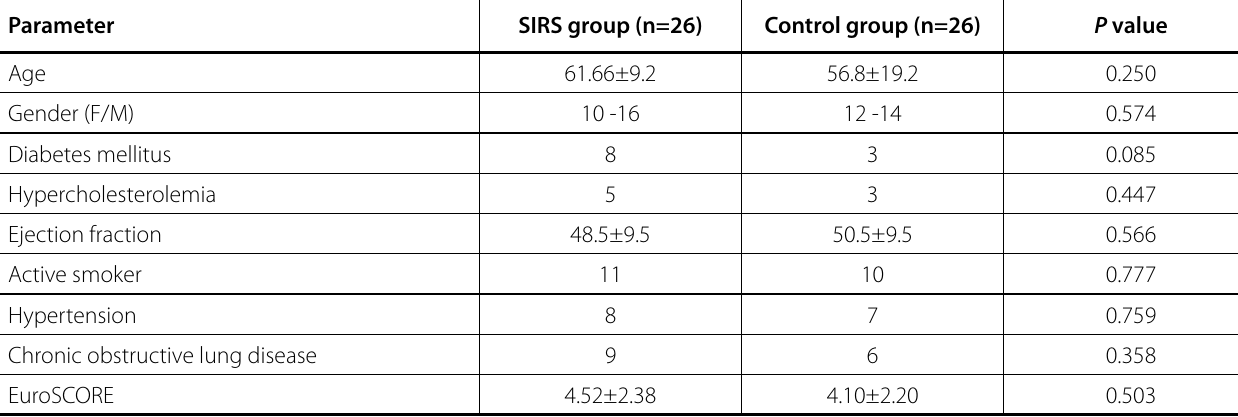
Table 1 . Baseline clinical and demographic